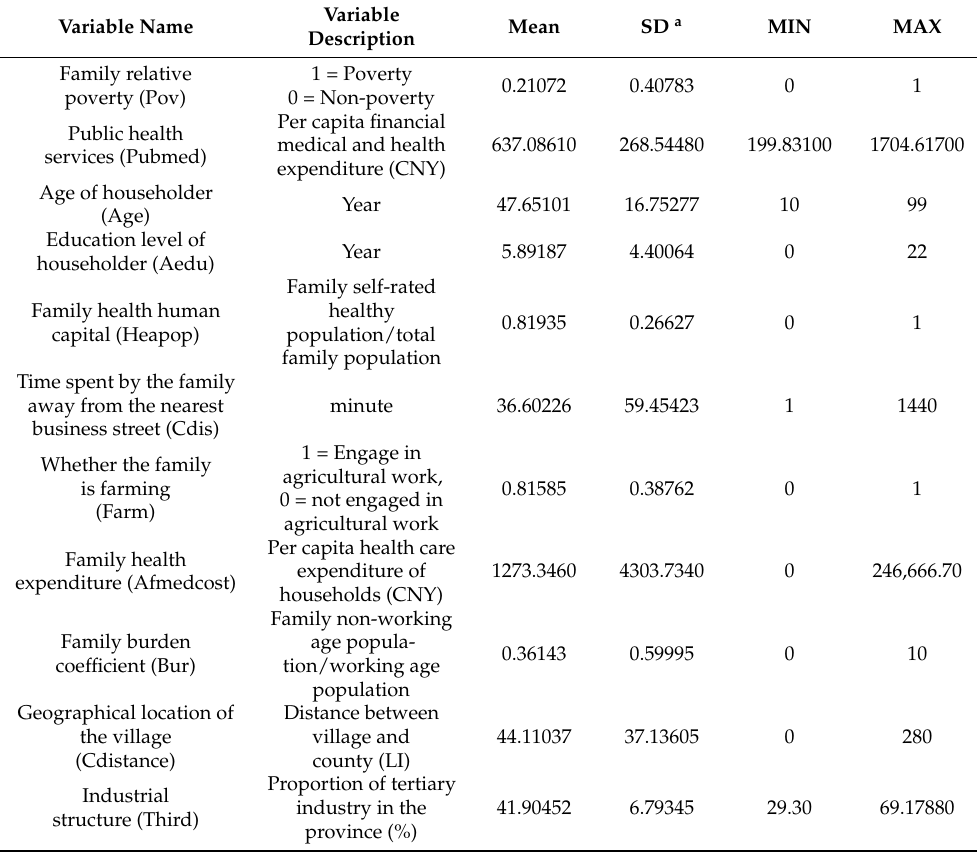
Table 1. Variable description and descriptive